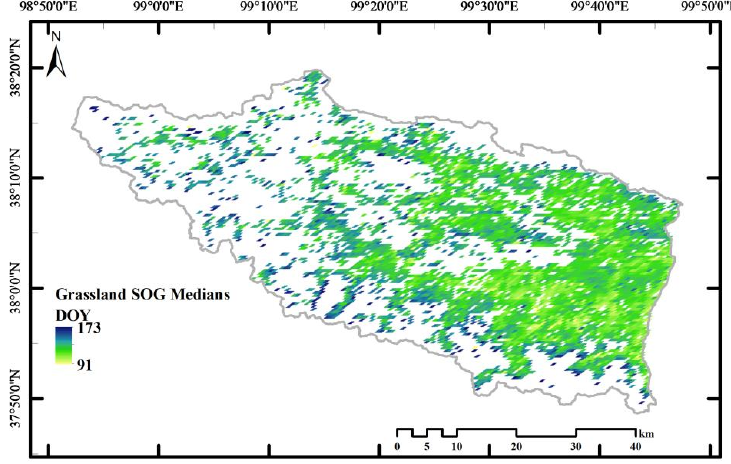
Figure 8. SOG average in the Muli region from 2014 to 2021.